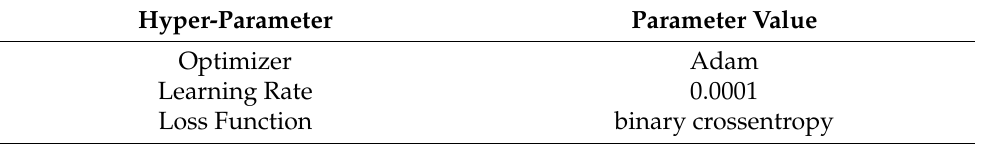
Table 1. Hyper-parameters settings.